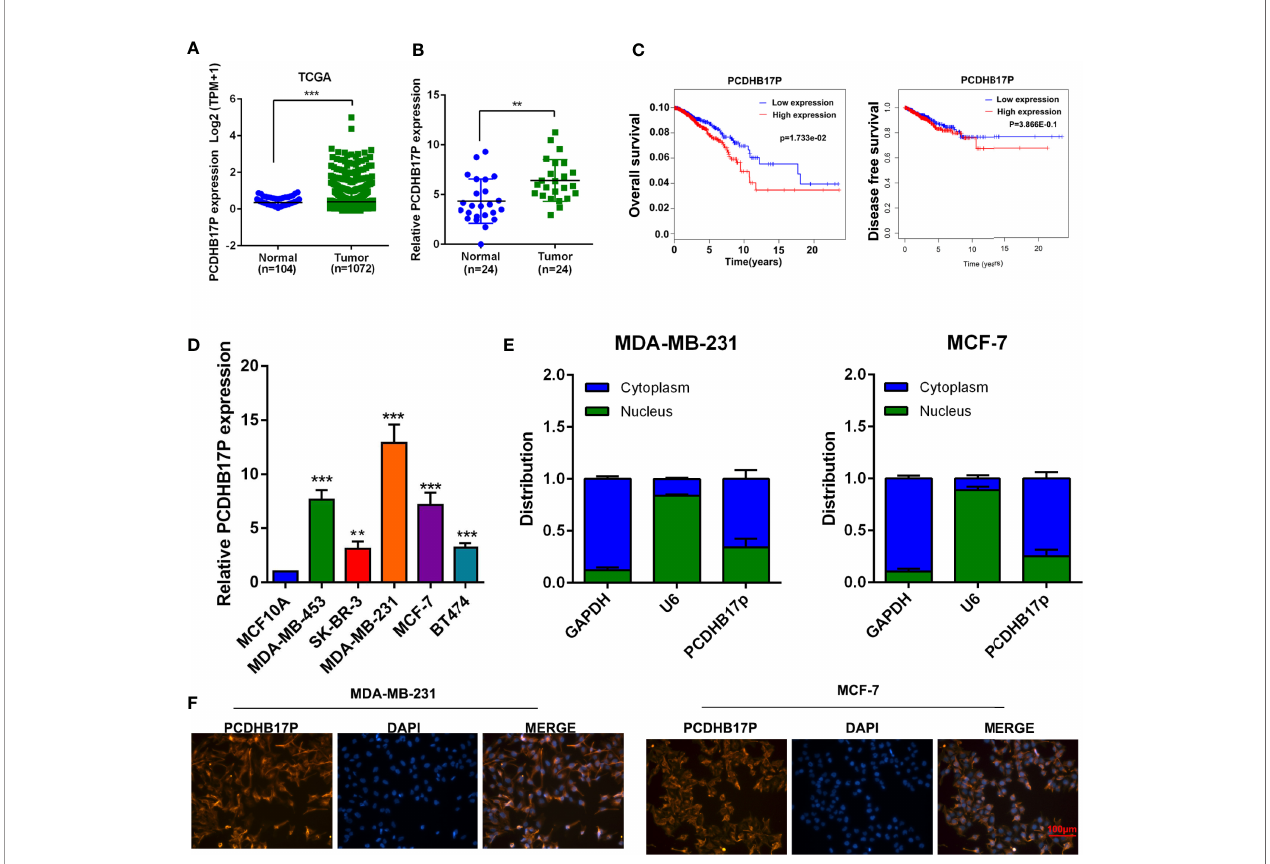
FIGURE 1 | PCDHB17P is speci fi cally up-regulated in breast cancer (A) Expression level of PCDHB17P in breast cancer samples and normal tissues from TCGA database. (B) The expression of PCDHB17P were detected in breast cancer samples and normal tissues by RT-qPCR. (C) Kaplan-Meier analysis of the correlation between PCDHB17P expression and overall survival/disease free survival in breast cancer TCGA dataset. Left: overall survival, Right: disease free survival (D) The expression of PCDHB17P were detected in breast cancer cells by RT-qPCR. (E) RT-qPCR assay of subcellular PCDHB17P expression in the nucleus and cytoplasm of MDA-MB-231 and MCF-7 cells. GAPDH and U6 were used as endogenous controls. (F) Subcellular localization of breast cancer cells detected by RNA-FISH. PCDHB17P is stained red and nuclei are stained blue (DAPI). ** P < 0.01, *** P <